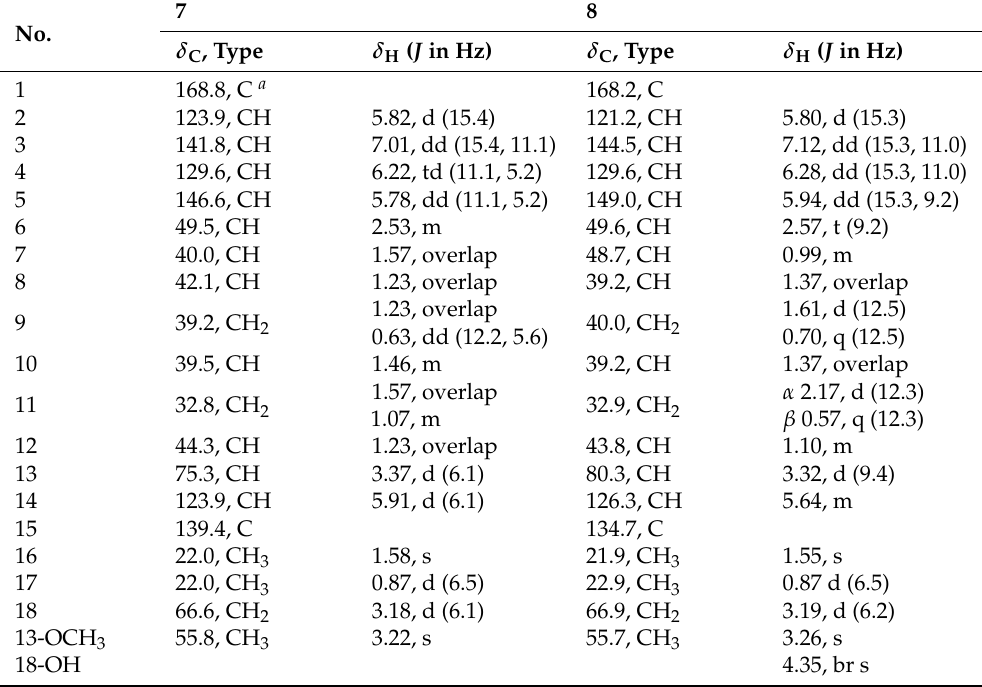
Table 3. 1 H and 13 C NMR data of compounds 7 and 8 in DMSO- d 6